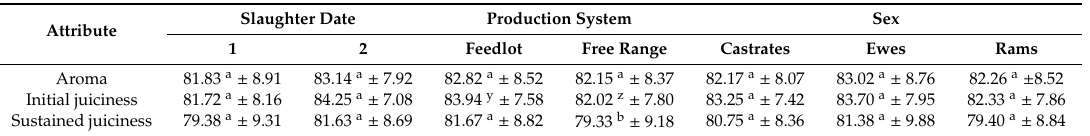
Table 3. Means ( ± s.d.) depicting the e ff ect of the slaughter date, production system and the sex on the sensory attributes of the Dorper lamb.